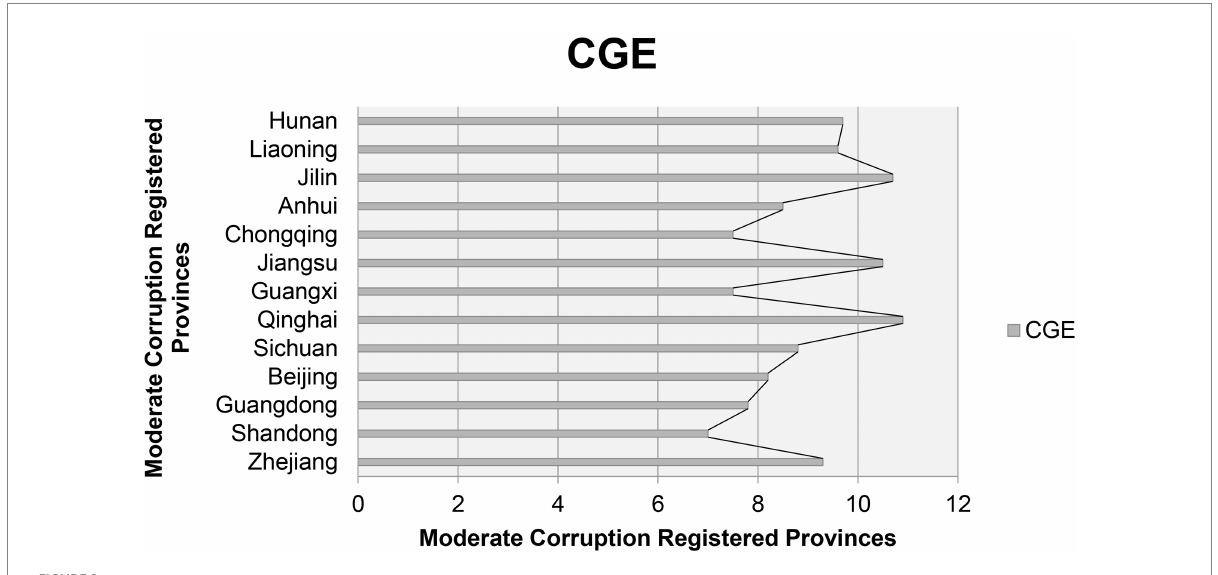
FIGURE 2 Moderate corruption registered